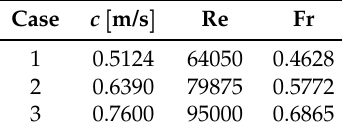
Table 2. Cylinder velocity and corresponding Reynolds and Froude